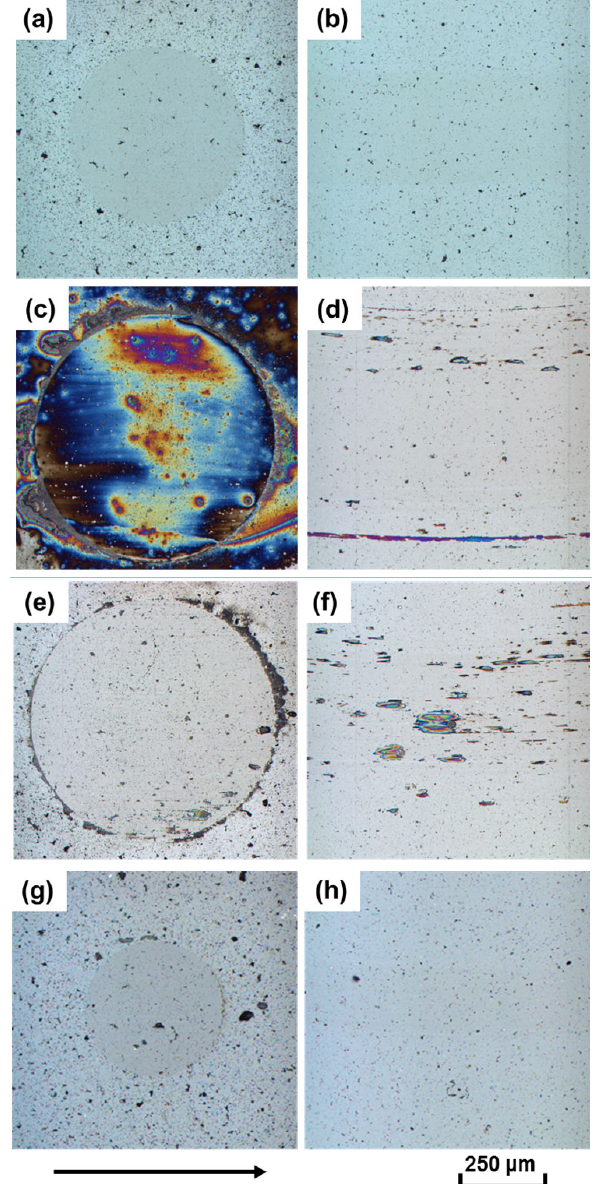
Fig. 8 Optical images of worn surfaces after rubbing-in in water-dispersed NDPs: (a, b) In NDP–COOH (1 wt%), (c, d) in NDP–OH (1 wt%), (e, f) in NDP–OH (0.1 wt%), and (g, h) in NDP–OH (0.001 wt%). Left (a, c, e, g) and right images (b, d, f, h) are worn surfaces on balls and disks, respectively. Arrows indicate sliding directions of counter